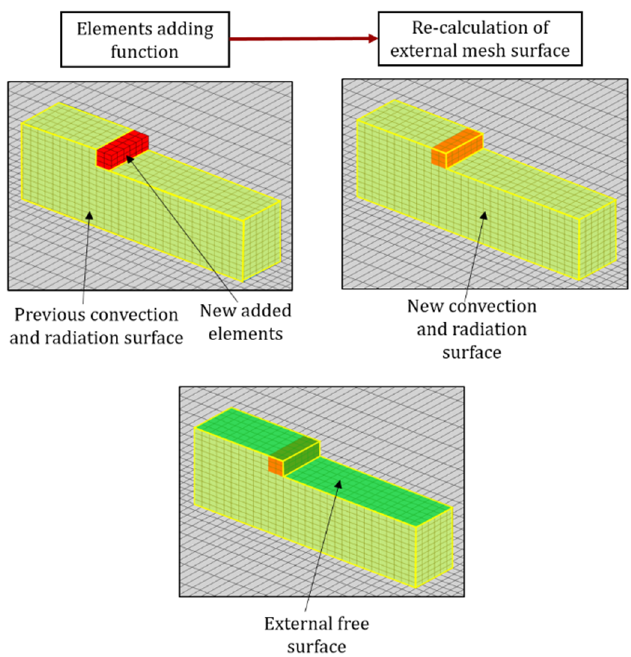
Fig. 2. External surface recalculation.